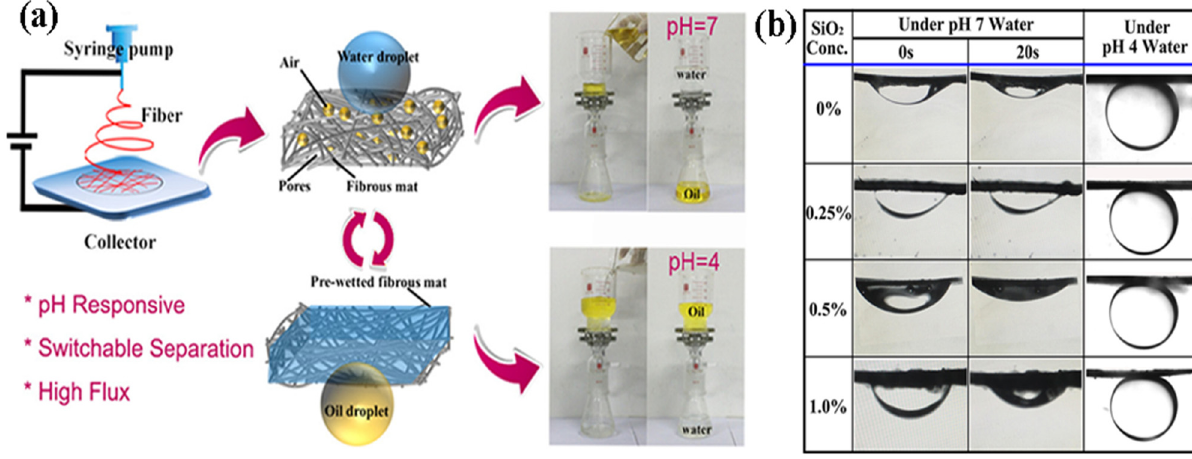
Figure 28: ( a ) ( PDMS - b - P4VP ) /SiO 2 fi ber mat preparation and pH - controllable oil/water separation process; ( b ) oil wettability of pure polymer and polymer/silica composite fi ber mats in aqueous media at di ff erent pH values [ 179 ] ; Copyright: 2016 with permission from